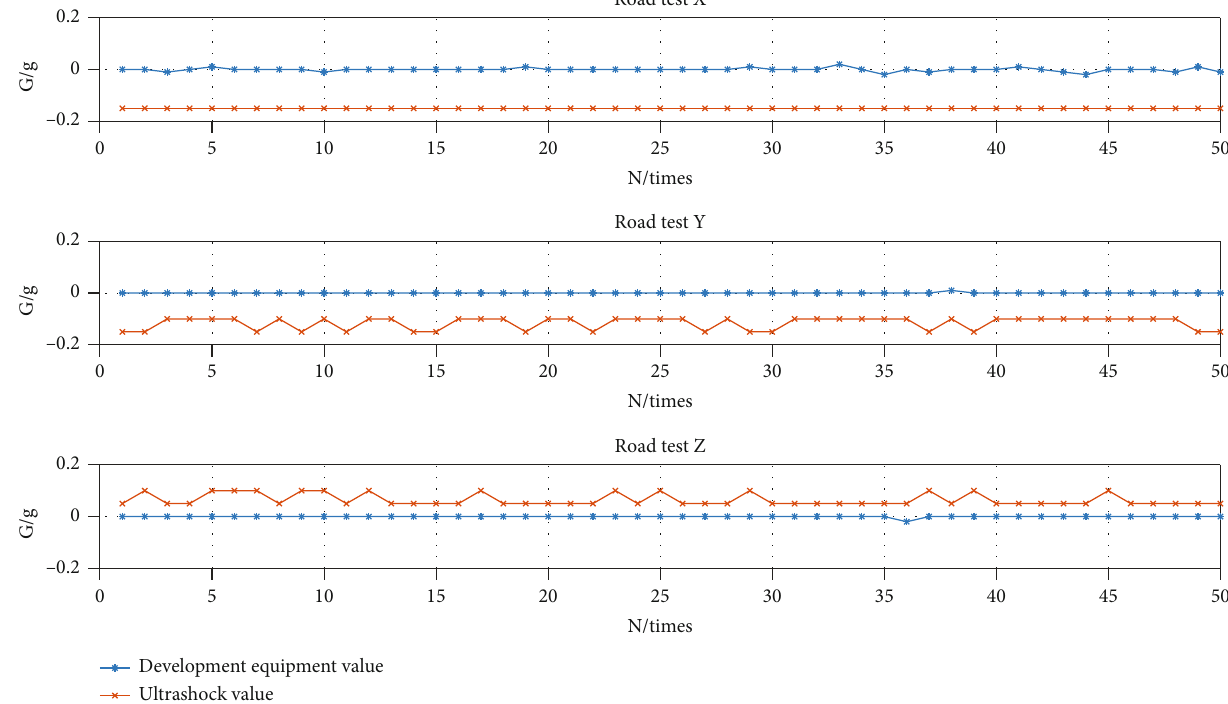
Figure 12: Road test comparison between the shock and vibration acceleration recorder and the similar foreign product acceleration measurement ( fi rst stage: beginning; second stage: work; and third stage: after transportation).